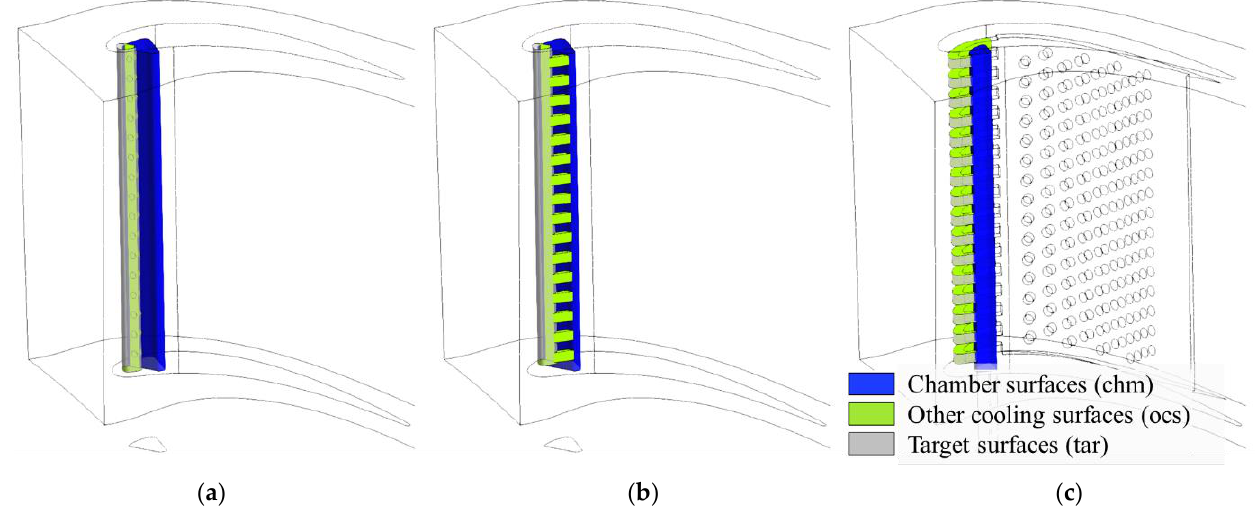
Figure 10. Cooling surfaces among different internal cooling structures; ( a ) Impingement cooling; ( b ) Swirl cooling; ( c ) Wall jet cooling.